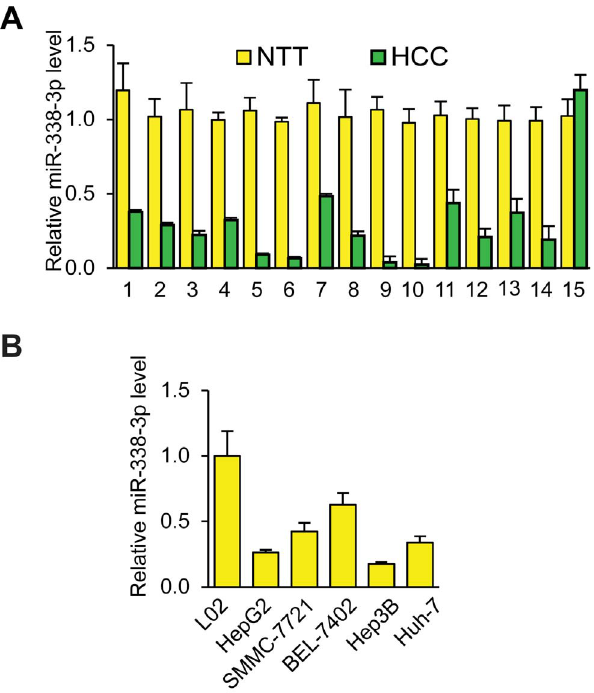
Fig. 1. Down-regulation of miR-338-3p in human Hepatocarcinoma (HCC) tissues and cell lines. (A) Real-time PCR analysis of miR-338-3p expression in 15 HCC specimens compared to their pair-matched adjacent non-tumor tissues (NTT). Expression levels were normalized to U6 snRNA and expressed as relative change compared to NTT. (B) Real-time PCR analysis of miR-338-3p expression in the liver cell line L02 and HCC cell lines HepG2, SMMC-7721, BEK-7402, Hep3B, and Huh-7. Expression levels were normalized to U6 snRNA and expressed as relative change compared to L02. Data are shown as mean ¡ SEM of three independent